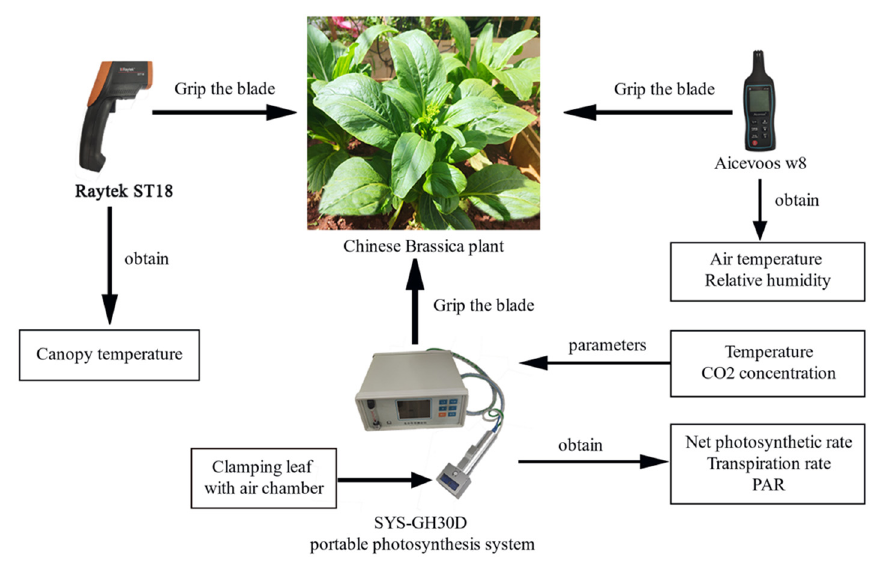
Figure 3. Equipment and processes of measurement in the experiment.